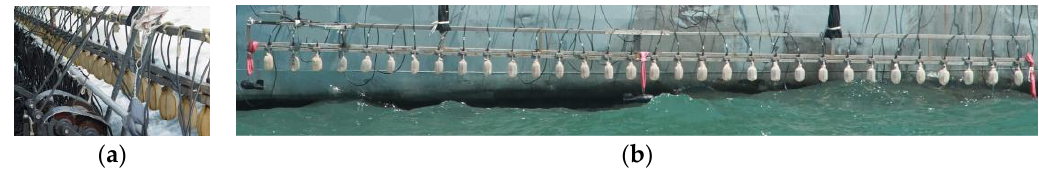
Figure 11. The ULA used in the marine trial. ( a ) Partial enlargement of the ULA; ( b ) The photograph of the ULA before it was put into water.